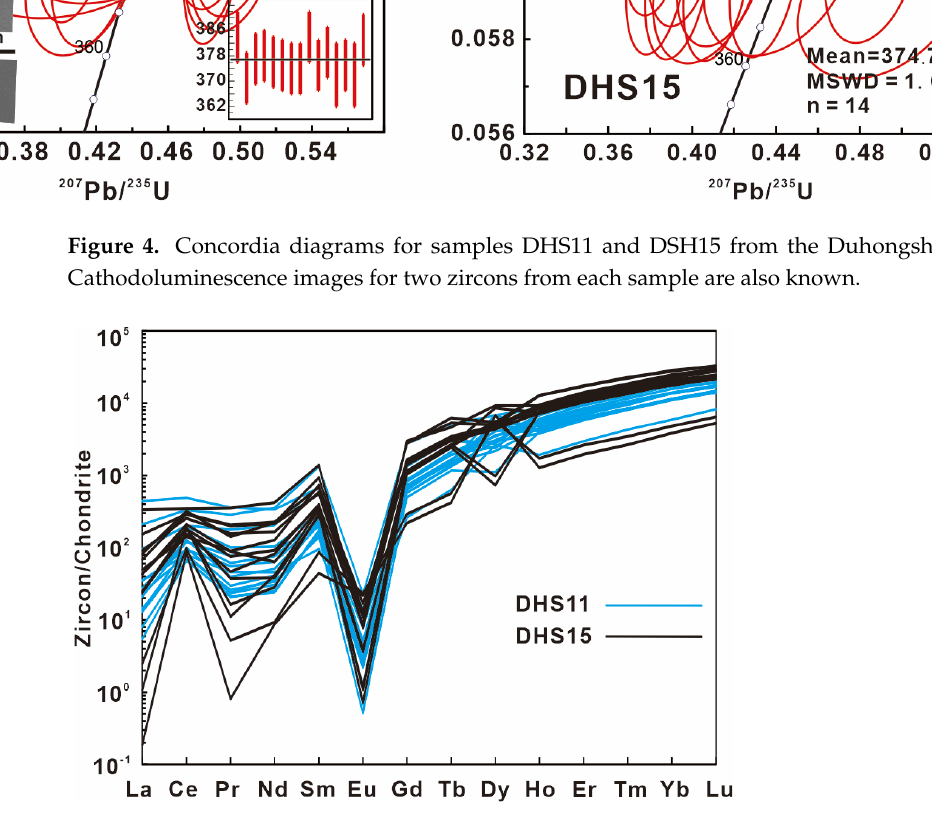
Figure 5. Chondrite − normalized rare earth element pattern for zircon from the Duhongshan granites. Chondrite values from [60].